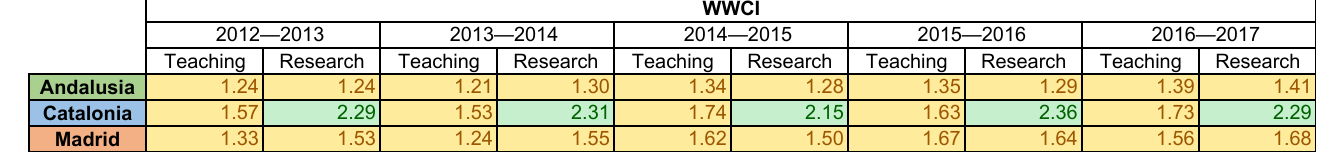
Figure A12. WWCI values of Andalusia, Catalonia and Madrid in their teaching and research